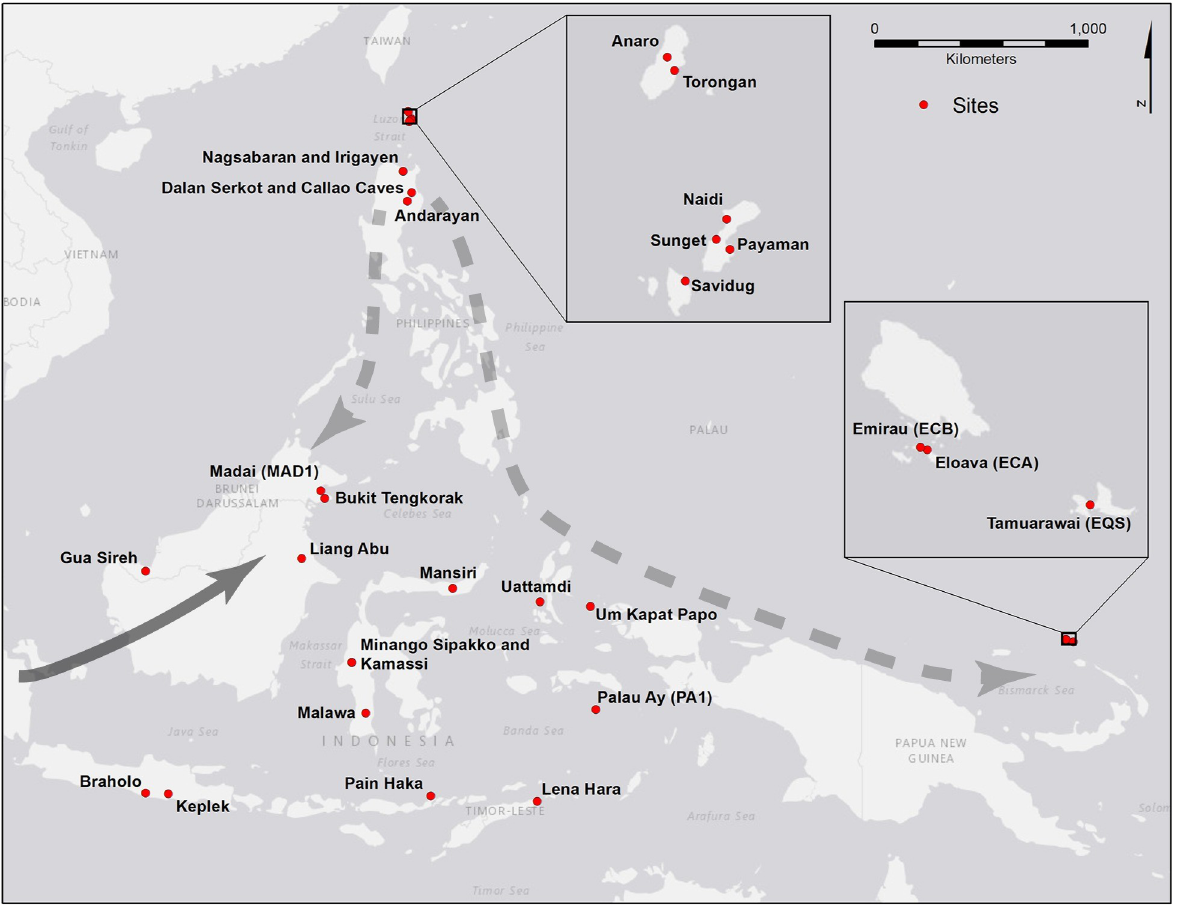
Fig 1. Map of Island Southeast Asia and near Oceania. Archaeological sites mentioned in the text and S1 File are shown. Arrows depict primary population movements associated with the OoT (dashed) and WRM hypotheses (solid). Basemap provided by